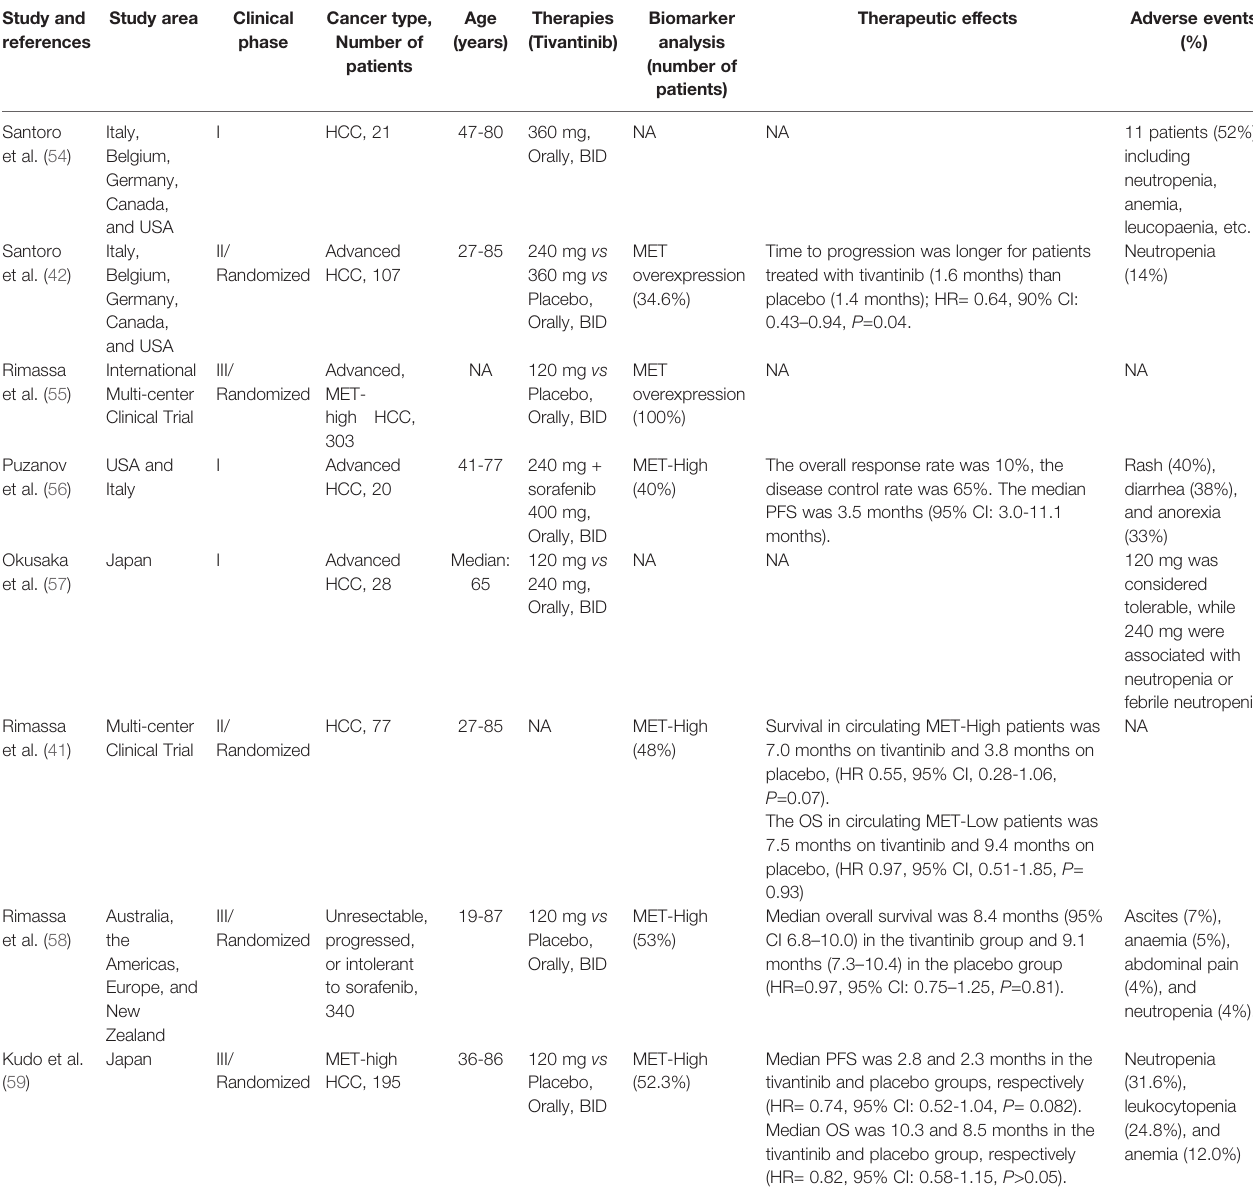
TABLE 2 | The characteristics of the 8 published phase 1/2/3 studies of tivantinib in